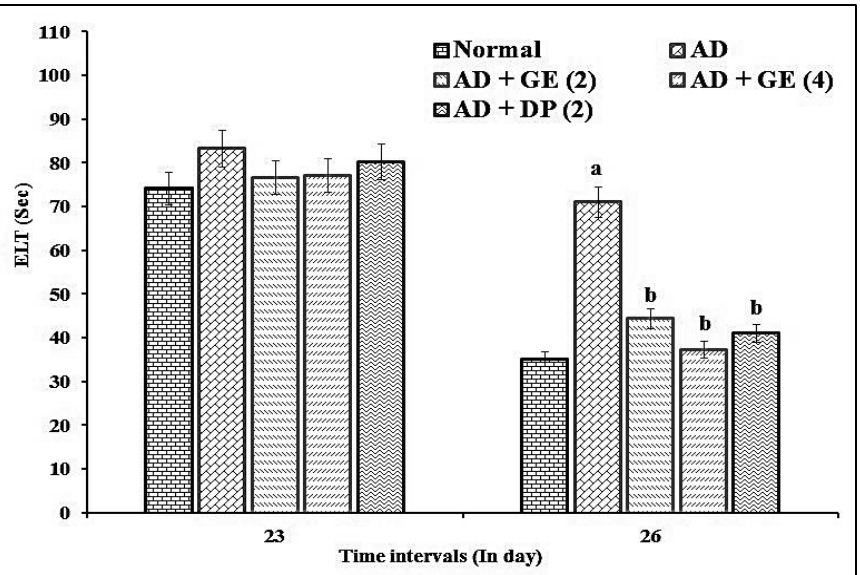
Figure 1. Effect of GE on ELT in MWM test assessment. Digits in parentheses indicate the dose in mg/kg. Data are expressed as the mean ± SD, n = 8 mice per group. a p < 0.05 vs. normal group; b p < 0.05 vs. AD group. Abbreviations : AD, Alzheimer’s disease; DP, donepezil; ELT, escape latency time; GE, gefitinib; Sec, seconds.